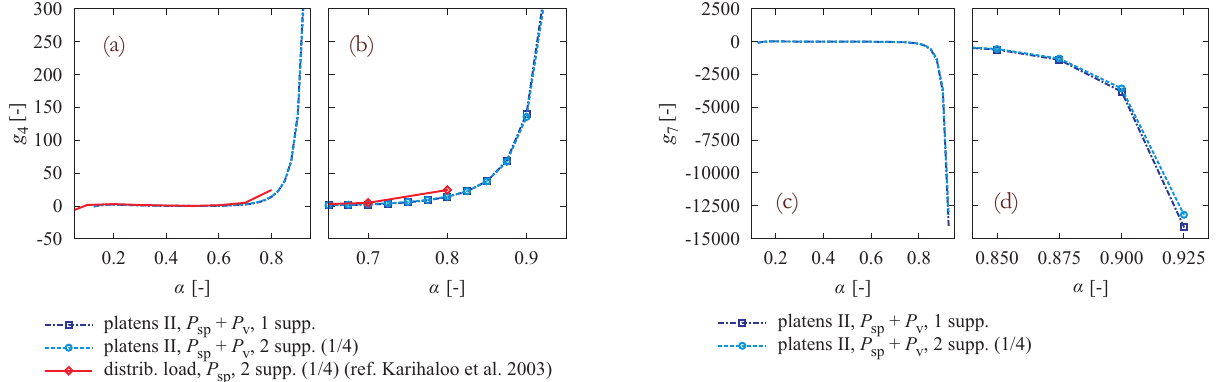
Figure 6: Shape functions g 4 and g 7 as functions of the relative crack length  for two support